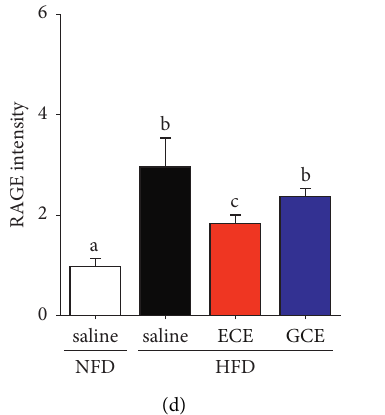
Figure 4: Effects of E . cava extract on TLR4, RAGE, and NF- κ B expressions in visceral fat of high-fat diet- (HFD-) induced obese mice. To validate expression of inflammation-related receptors in visceral fat of standard normal fat diet with 0.9% saline (NFD/saline; open bar), HFD with 0.9% saline (HFD/saline; black bar), HFD with E . cava extract (HFD/ECE; red bar), and HFD with Garcinia cambogia extract (HFD/GCE; blue bar) group, tissue section slides were prepared. (a, c) The confocal microscopic images show toll-like receptor 4 (TLR4; (a) green), the receptor of AGE (RAGE; (c) green) expressions were assessed by immunostaining, and nuclei were stained DAPI (blue). (b, d) Quantitative green fluorescence intensity graphs show folds of those of the NFD/saline group, and these graphs show average expression levels in representative images. (e) NF- κ B expressions were assessed by qRT-PCR. Scale bar � 50 μ m. The same letters represent no significant difference ( p < 0 .